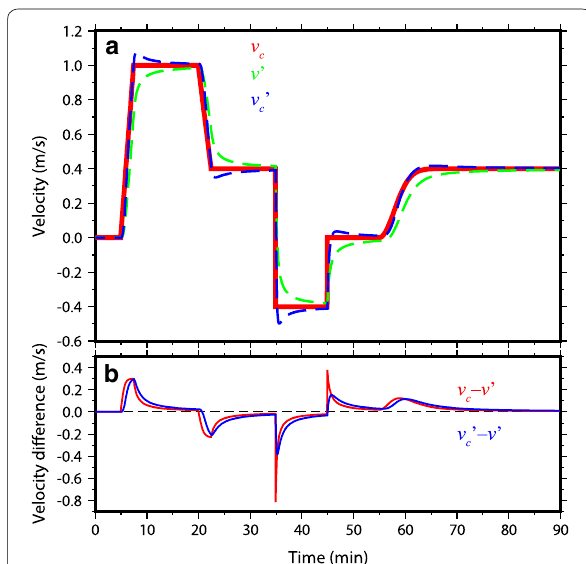
Fig. 7 Test numerical simulation based on Eq. (2). In a , red, green, and blue lines indicate tsunami current given arbitrarily ( v c ), ship response ( v ′ ) simulated from v c , and tsunami current ( v c ′ ) simulated from v ′ , respectively. In b , red and blue indicate v c – v ′ and v c ′ – v ′ ,